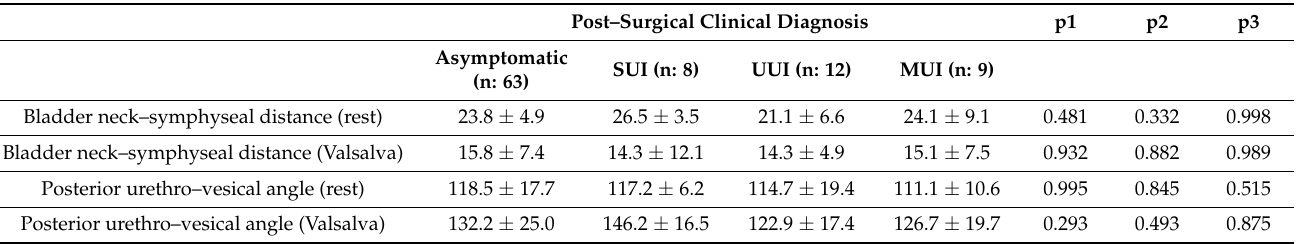
Table 3. Ultrasound evaluation of the study population differentiating asymptomatic patients from patients with SUI, UUI, MIU after placement of the